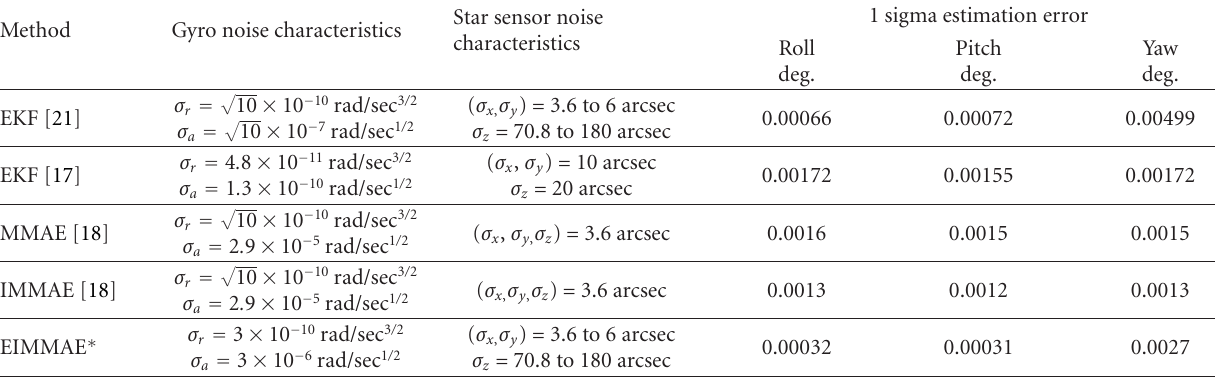
Table 5: Comparison of attitude estimation methods.